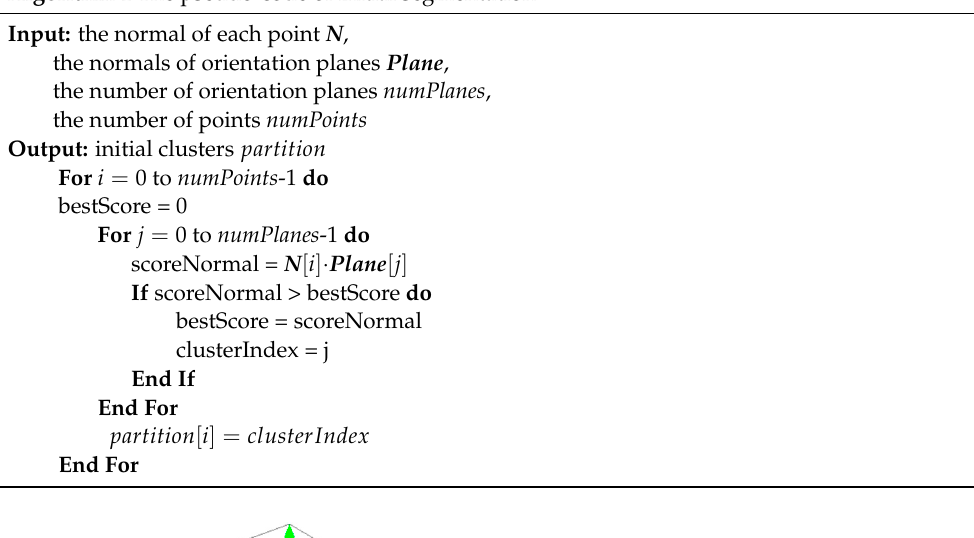
Algorithm 1 The pseudo-code of initial segmentation